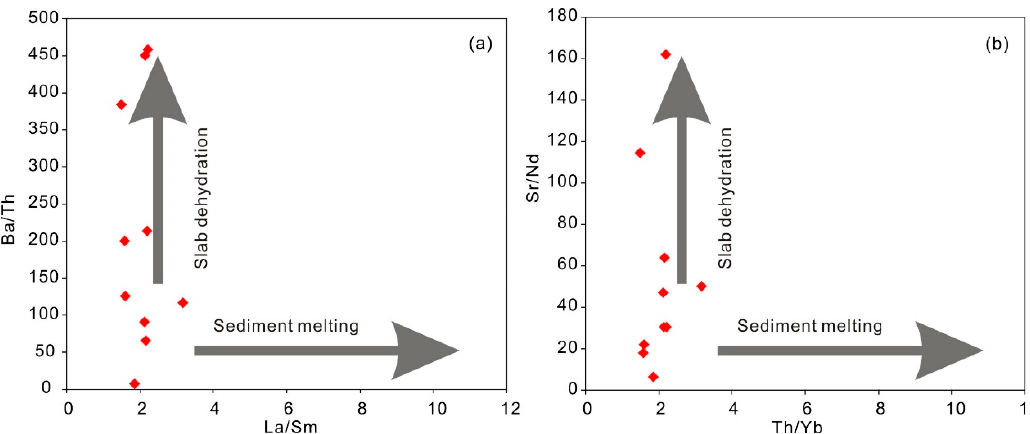
Figure 10. ( a ) Plot of Ba/Th vs. La/Sm for the Haoyaoerhudong gabbro (after [63]). ( b ) Plot of Th/Yb vs. Sr/Nb for the Haoyaoerhudong gabbro (after [64]). vs. Sr/Nb for the Haoyaoerhudong gabbro (after